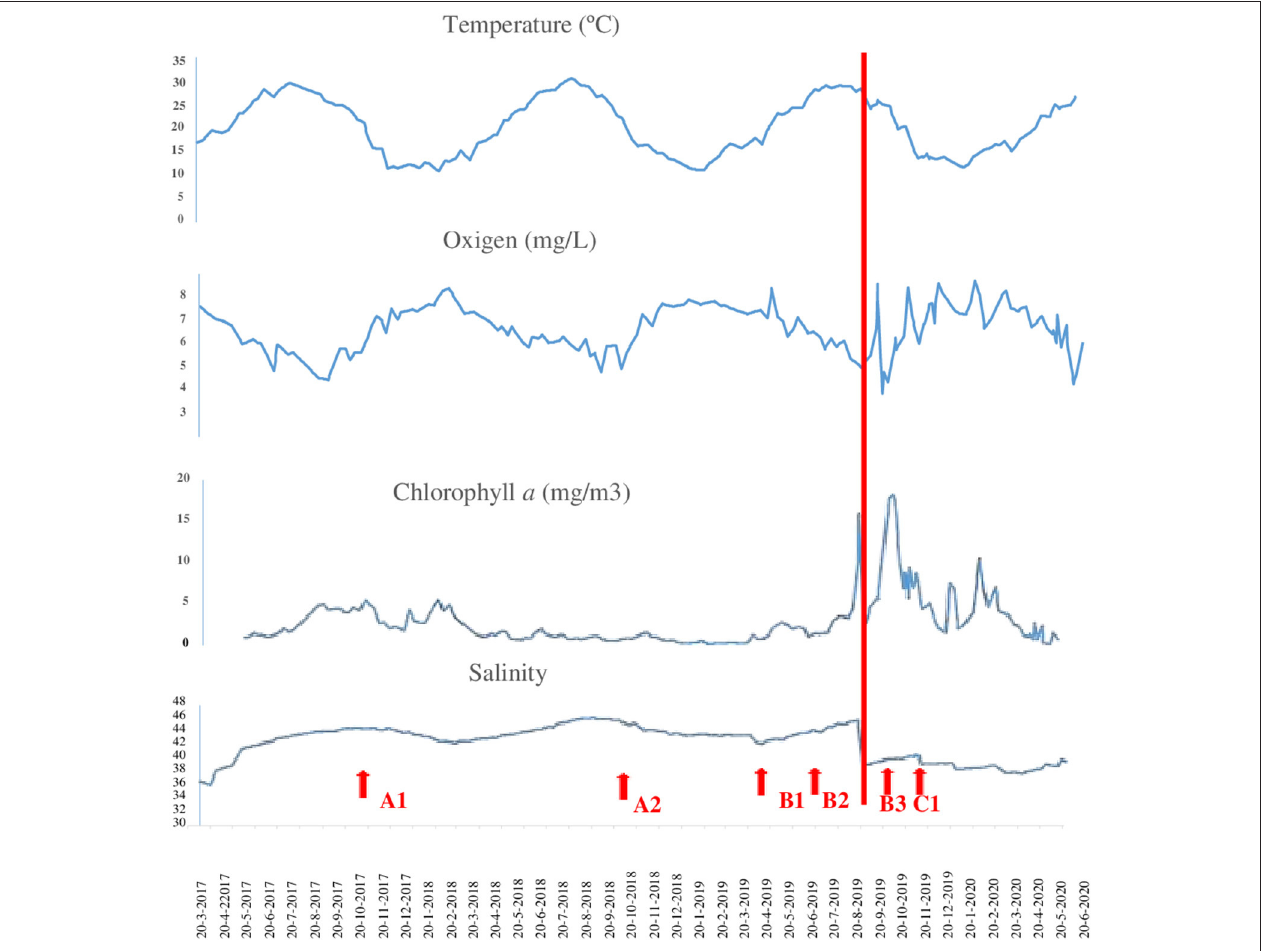
FIGURE 4 | Changes in the concentration of chlorophyll a , oxygen, temperature, and salinity in the Mar Menor water column during the study period. Data were obtained from the General Directorate of the Mar Menor of the Ministry of Water, Agriculture, Livestock, Fisheries, and Environment of the Autonomous Community of the Region of Murcia (https://www.canalmarmenor.es). The red line indicates the extreme rainfall event in 2019. The red arrows indicate the different sampling times.